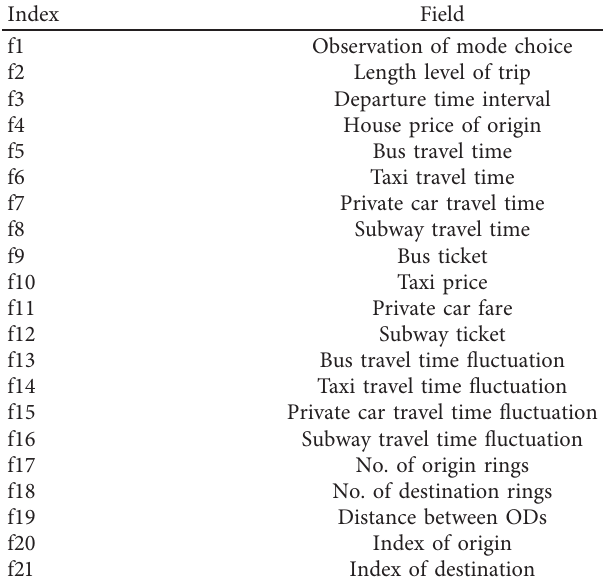
Table 1: Fields of the traffic mode choice